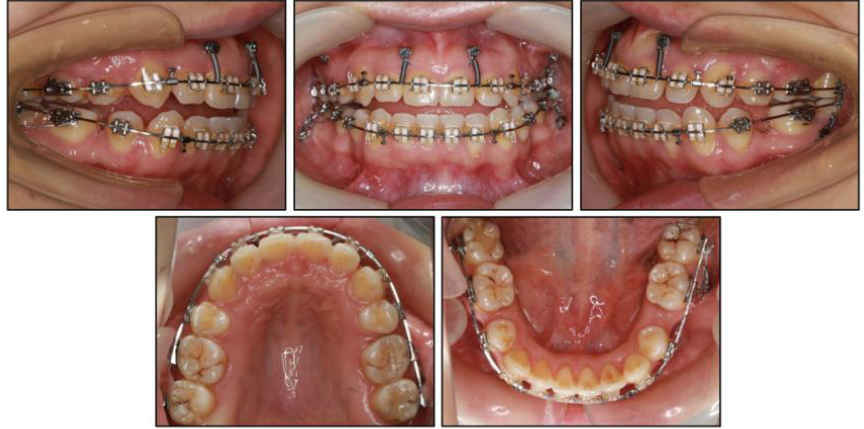
Figure 5. Twenty months into treatment, four miniscrews were used to intrude the maxillary anterior teeth and mandibular molars to achieve counterclockwise rotation of the mandible.